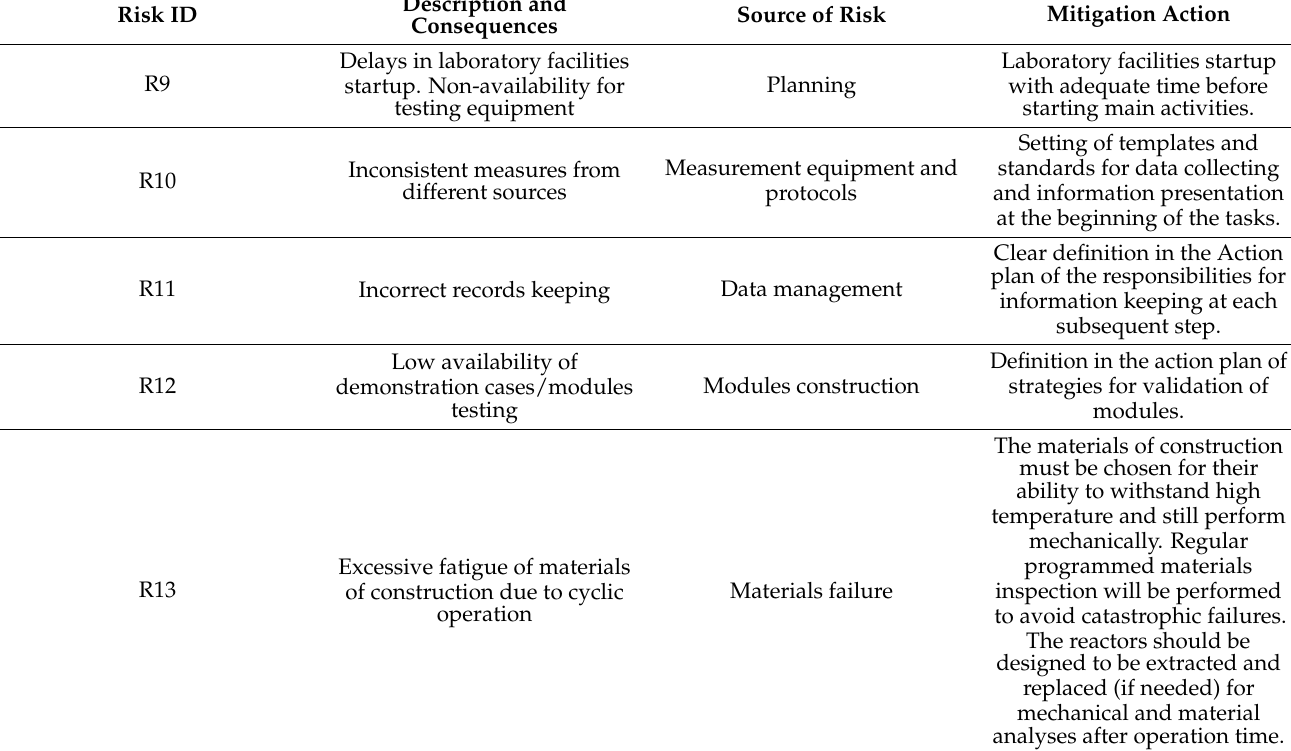
Table 3. Definition of main risks affecting the testing and operation of the pilot